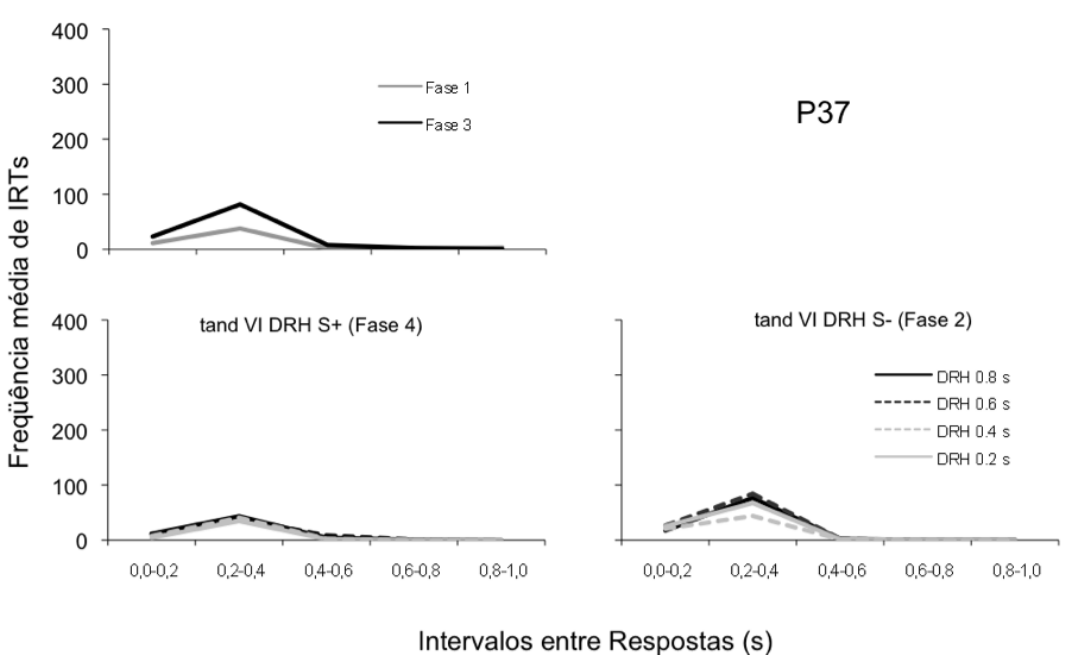
Figura 3 . Distribuição média de intervalos entre respostas de observação (i.e., respostas na presença do disco iluminado pela cor branca) em cada uma das fases e condições experimentais, para os Pombos 32, 36 e 37, nos respectivos Painéis A, B e